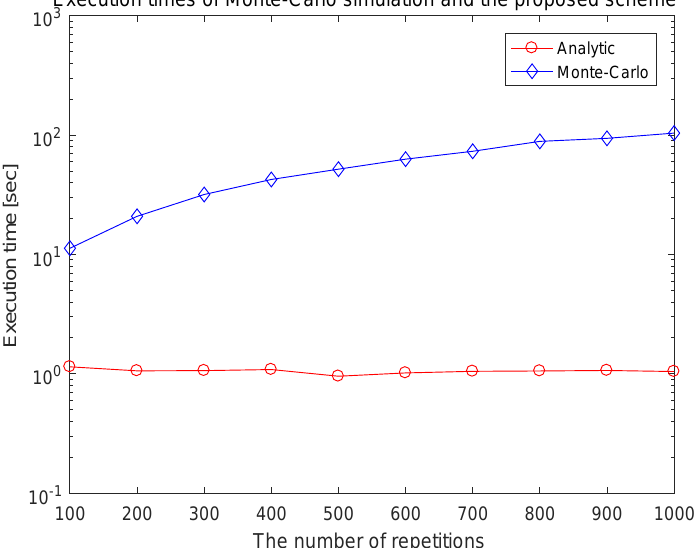
Figure 5. Comparing the execution times between Monte Carlo simulation-based MSEs and Analytic